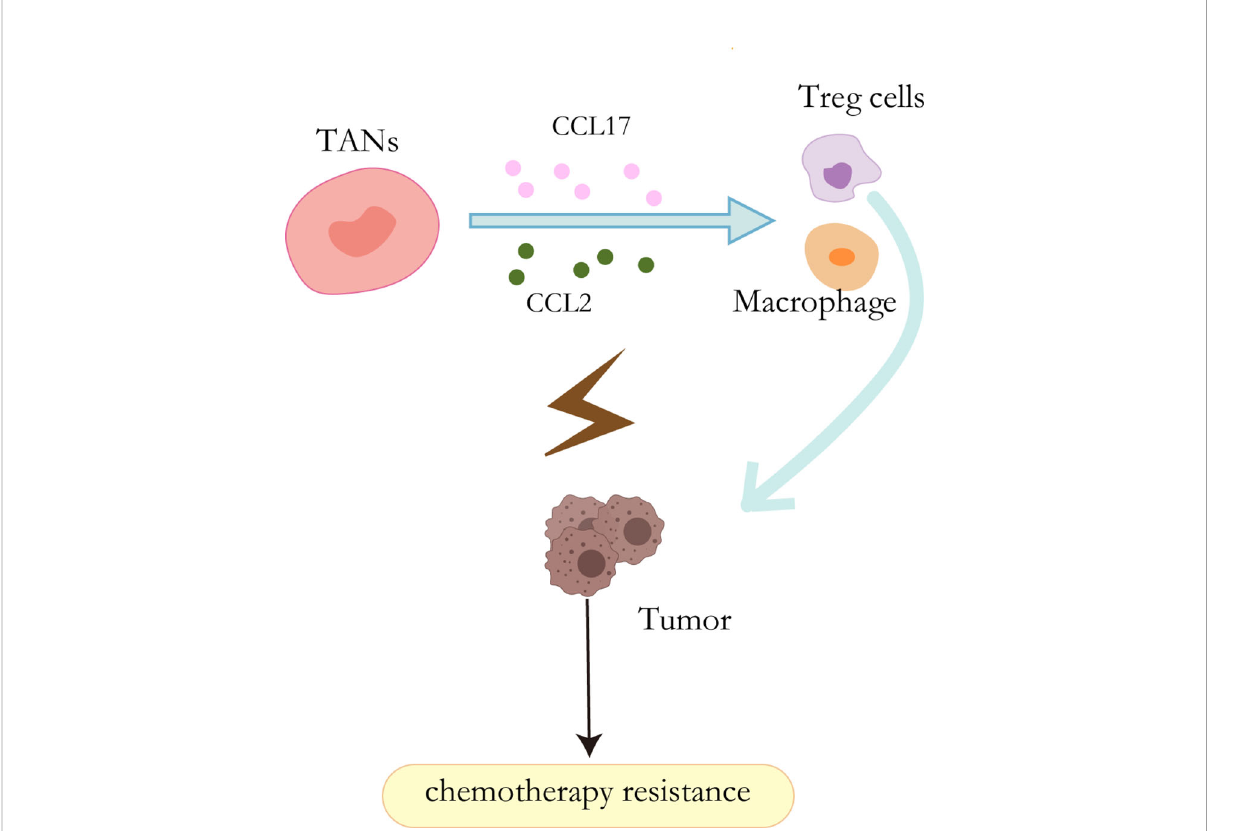
FIGURE 4 Resistance mechanisms of TANs. CCL2 and CCL17 secreted by TANs can mediate the intratumoral invasion of macrophages and Treg cells, thereby stimulating angiogenesis and promoting sorafenib